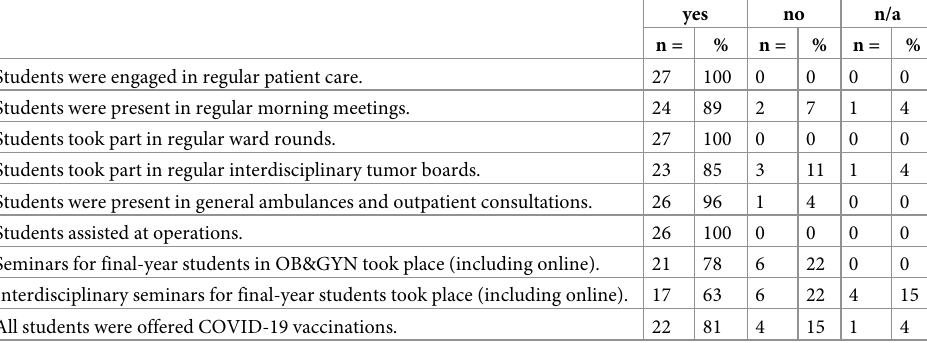
Table 4. The impact of the COVID-19 pandemic on the final year of medical studies.